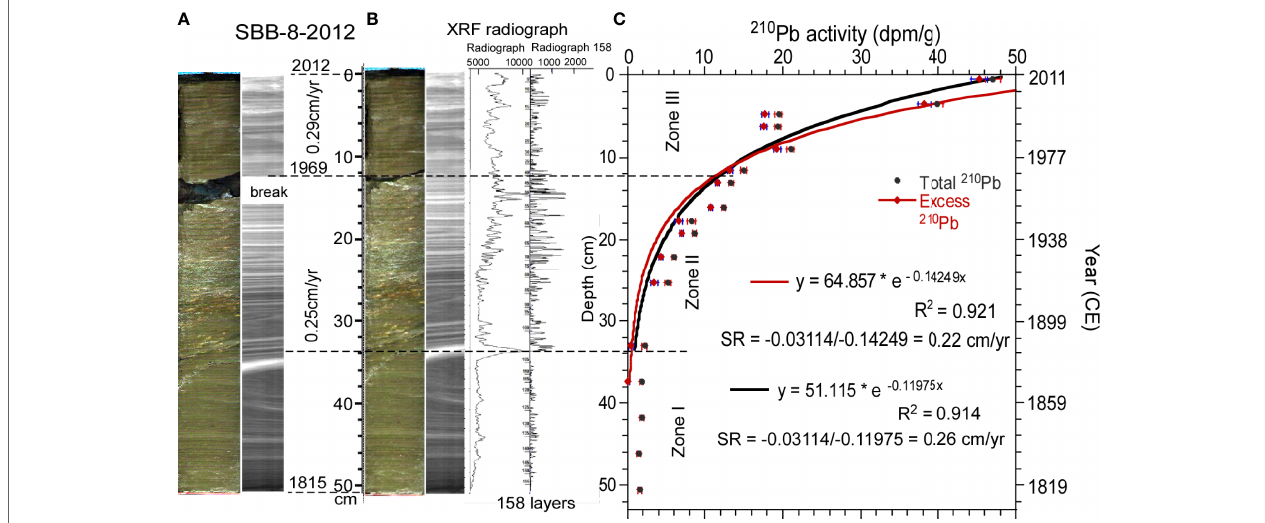
FIGURE 2 | Picture, X-ray radiograph, lamination counting and 210 Pb dating of Core SBB-8-2012. (A) Core photo during XRF scanning and sampling. The breaking gap between 12cm and 13cm was formed during the transportation from USA to Taiwan. (B) Core photo after adjusted the depths to remove the breaking gap. The lighter bands in the radiograph reflect the layers with less density. The brightest band at 34 cm indicates an organic rich layer in which all elemental contents by iTRAX XRF scanning are low. (C) 210 Pb profile of the core. The constructed ages are shown on the right-hand side of the plot. The red curve and black curve fittings are using different ending depths of excess 210 Pb, which result different sedimentation